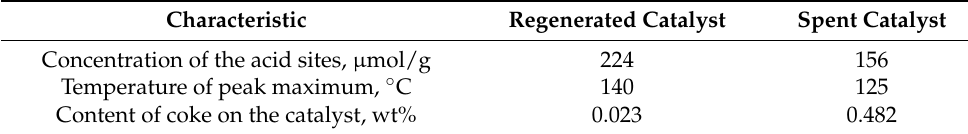
Table 2. Acid properties of the spent and regenerated catalysts. Characteristic